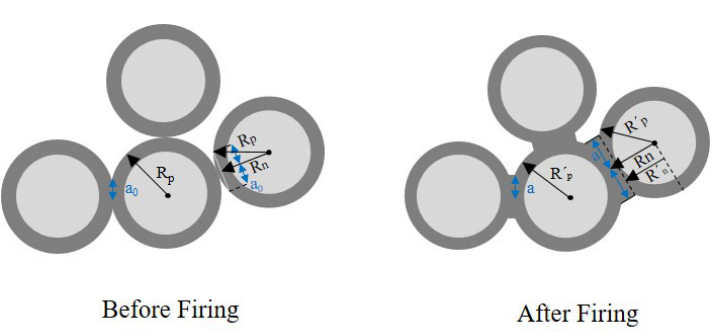
Figure 9. Development of particle connections and neck radius for compression and firing; adapted from